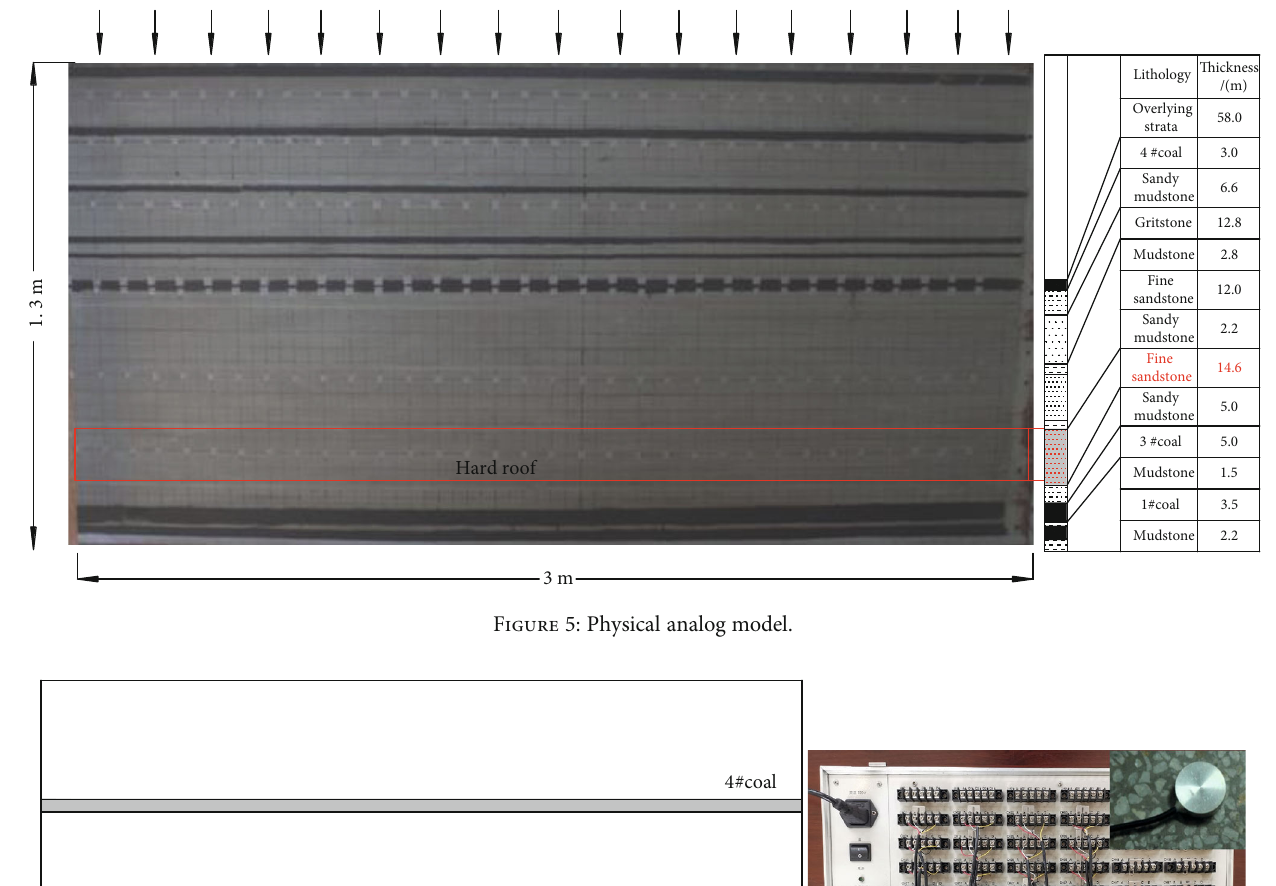
Figure 6: Stress sensor and monitoring